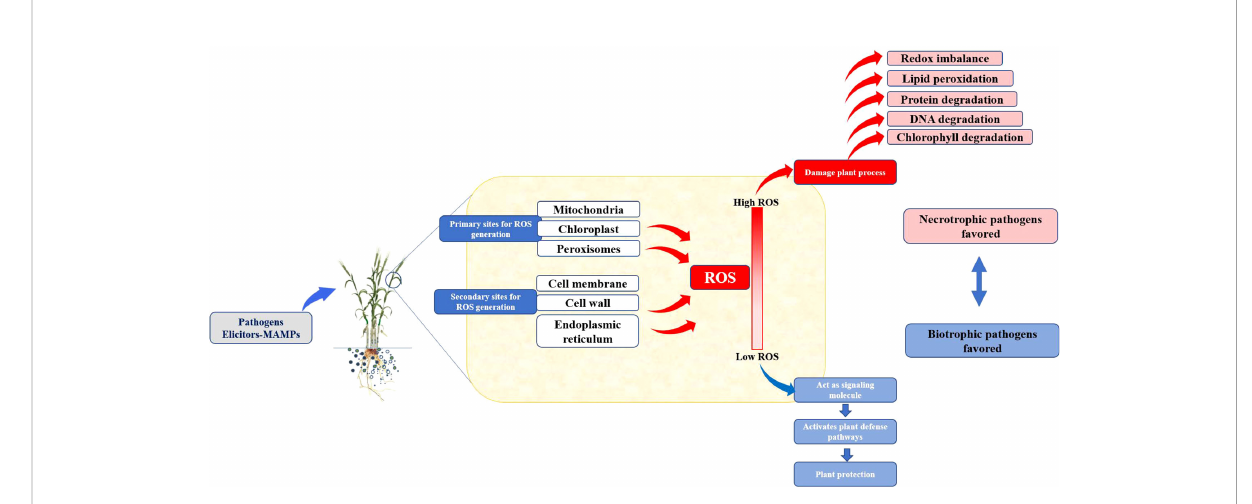
FIGURE 2 Response of biotrophic and nectrotropic pathogens to the ROS burst in host